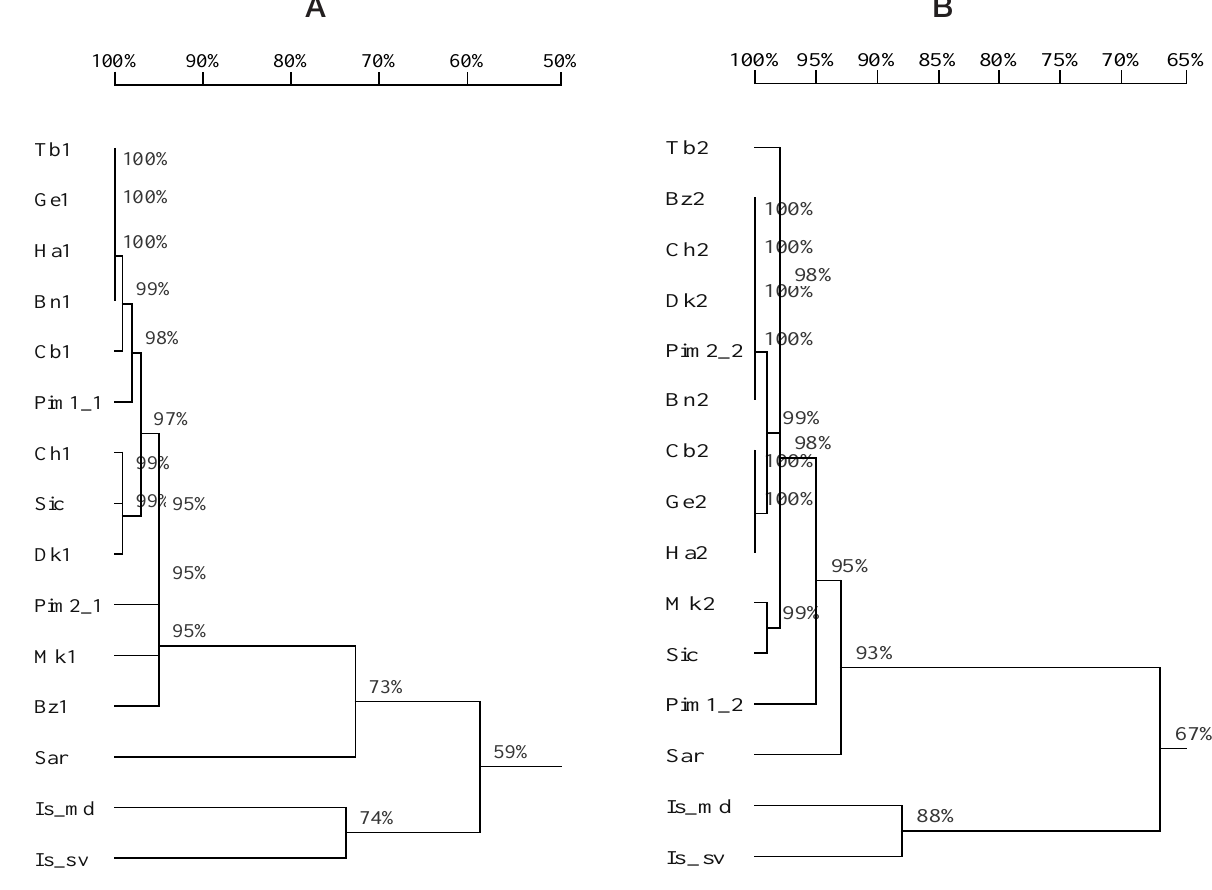
Fig. 6. Phylogenetic tree showing relationships among intergenic regions of Tunisian isolates and other known TYLCV strains. Numbers above the branches indicate percentage of homology. Horizontal branches are proportion- al to sequence homologies. 6a, sequence comparison of IR1 region (the end part of the genome); 6b, sequence com- parison of IR2 region (the starting of the